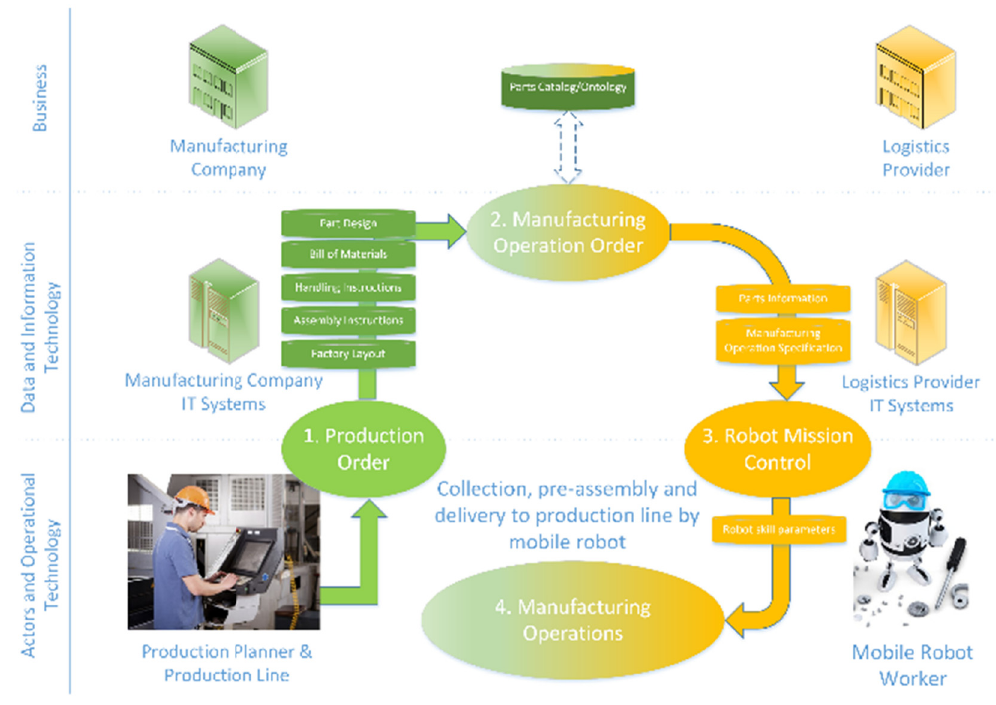
Figure 7: Information fl ow in the digital manufacturing operation services.